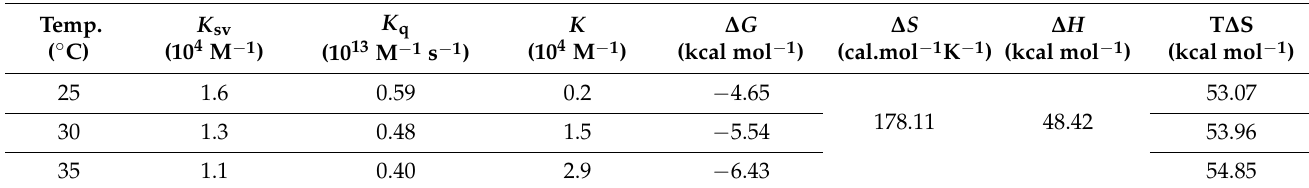
Table 2. Binding and thermodynamic parameters obtained for coumaric acid– α - amylase interaction obtained through fluorescence